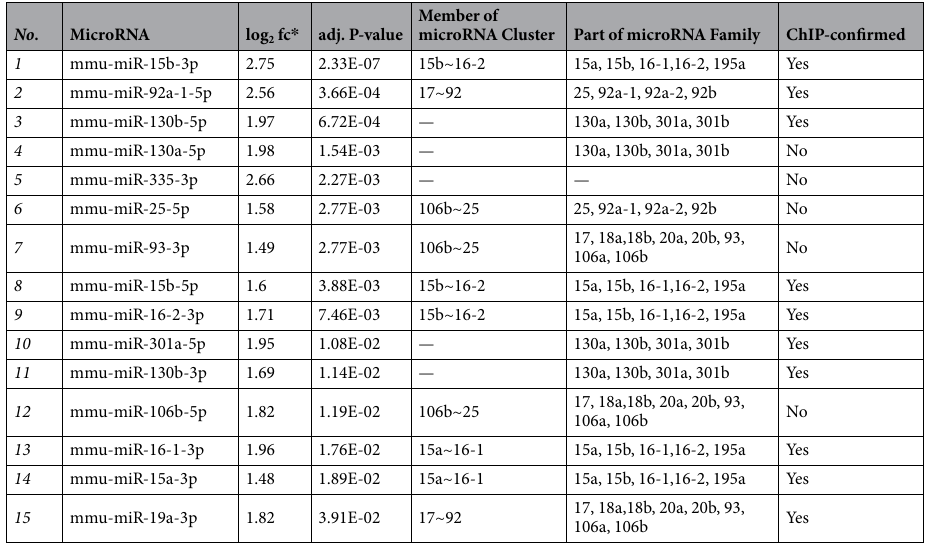
Table 2. The miRNAs with putative Foxm1 binding sites that are most markedly upregulated in NSCs. * NSC vs.